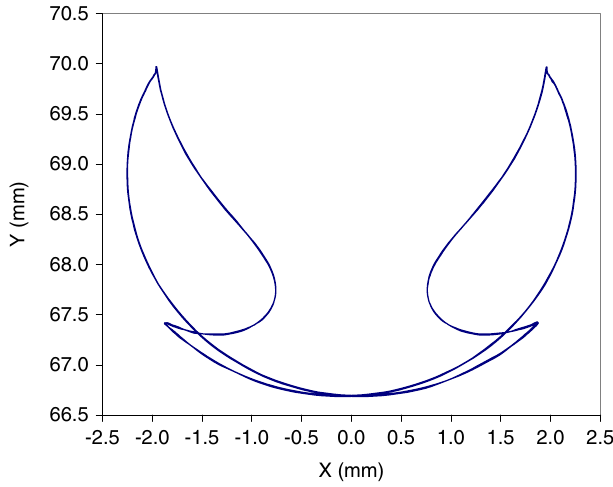
FIG. 13. Second order multipactor